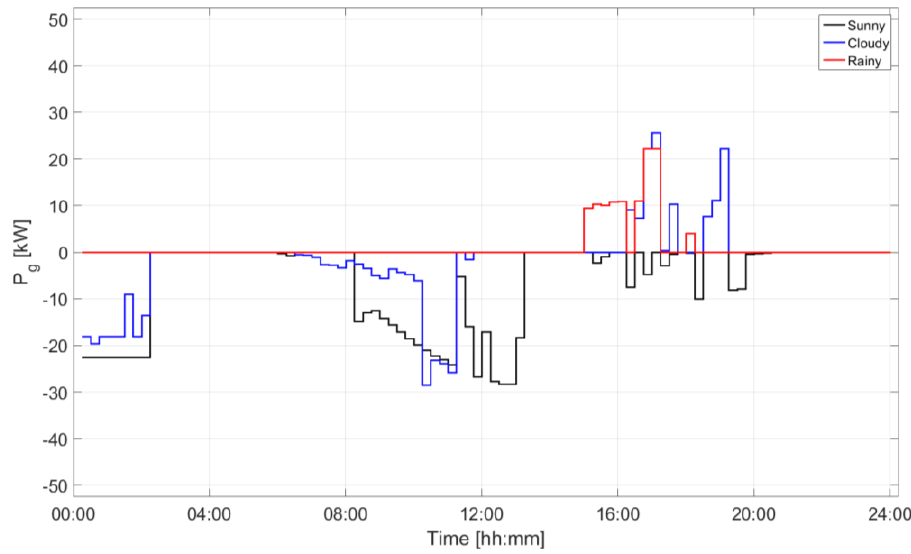
Figure 7. Power exchanged with the utility grid in the three days.